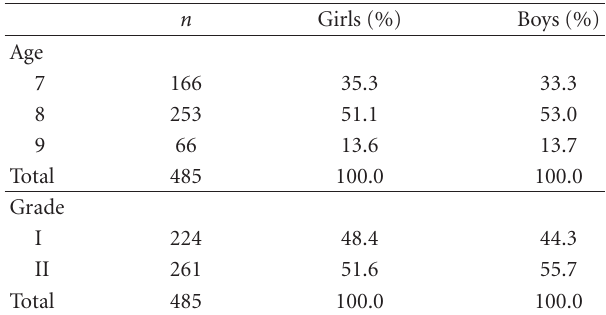
Table 1: Distribution of the children by age, grade, and